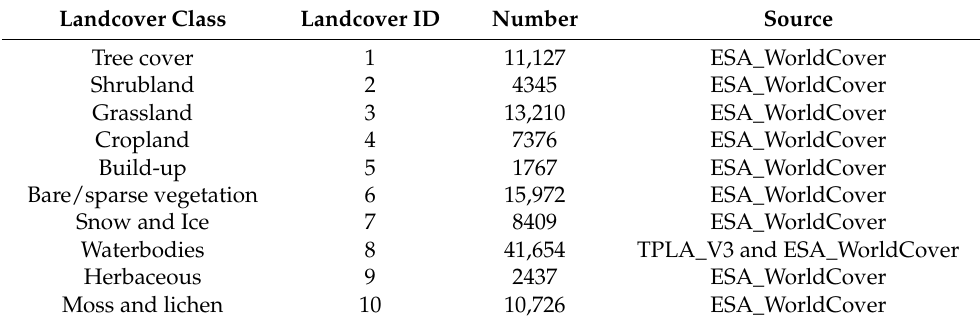
Figure 3. Mosaic images under removing clouds were synthesized in false color in bands 5, 4, and 3, and stretched with 2.5 standard deviations. ( a ) The cloud removal mosaic image with QA_PIXEL band, IMAGE_QUALITY_OLI wat set to 9, and median function. However, there are still a lot of clouds in the northwest and southeast regions. ( b ) The cloud removal mosaic image with QA_PIXEL band, IMAGE_QUALITY_OLI wat set to 9, and min function. The result shows that the cloud removal effect is better, but the shadow effect is enhanced. ( c ) The cloud removal mosaic image with QA_PIXEL band, CLOUD_COVER wat set to 20, and min function. Mosaic results cannot cover the study area, and some clouds are still obscuring the northwest. ( d ) The cloud removal mosaic image with QA_PIXEL band and piecewise mosaic. The results show that the cloud removal effect is relatively apparent, the shadow enhancement effect is relatively small, and the coverage of the study area is complete. Table 1. Landcover